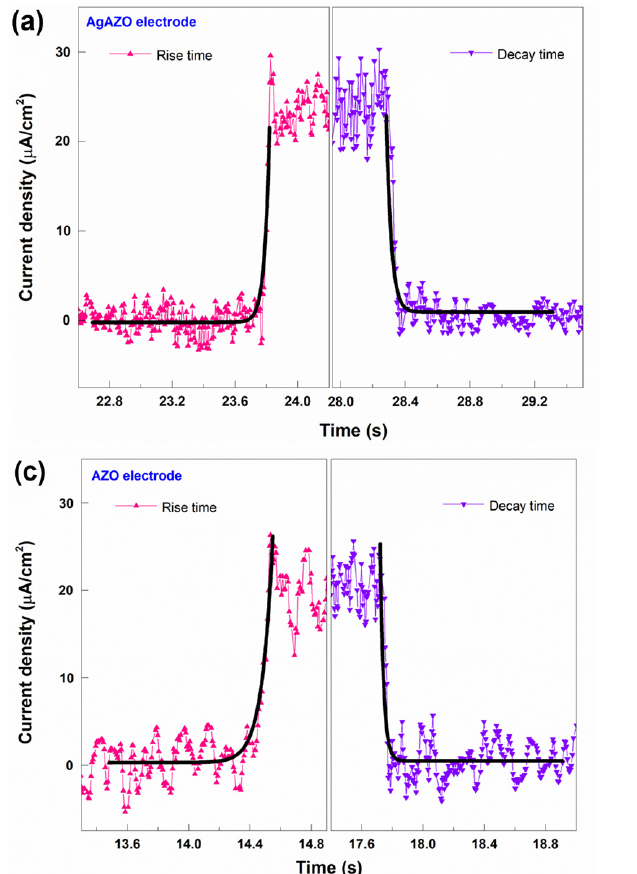
of Ag thin films; Figure S2: Thickness-dependent SEM images of AZO thin films; Figure S3: Structural characteristics of Ag:AZO thin film depending on thickness; Figure S4: AFM images of the Ag thin film as a function of thickness; Figure S5: AFM images of the AZO thin film as a function of thickness; Figure S6: Sustainability of Ag:AZO photodetector after 6